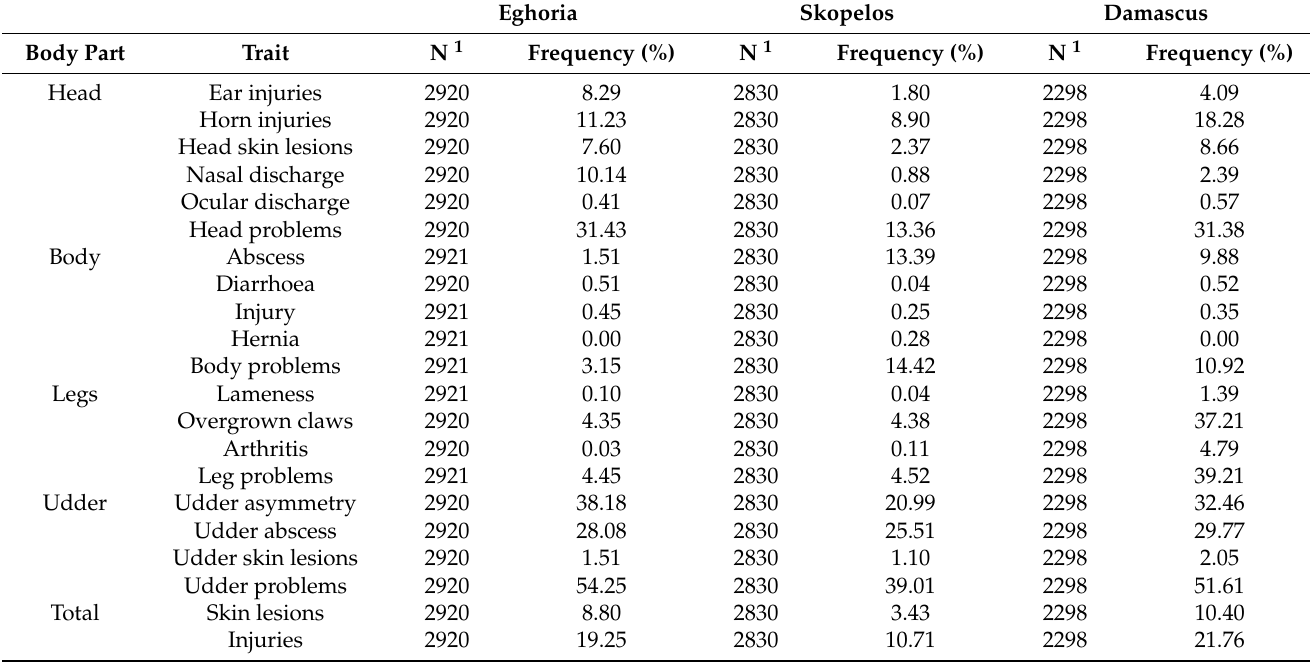
Table 4. Frequency (%) of welfare issues in the studied goat breeds.